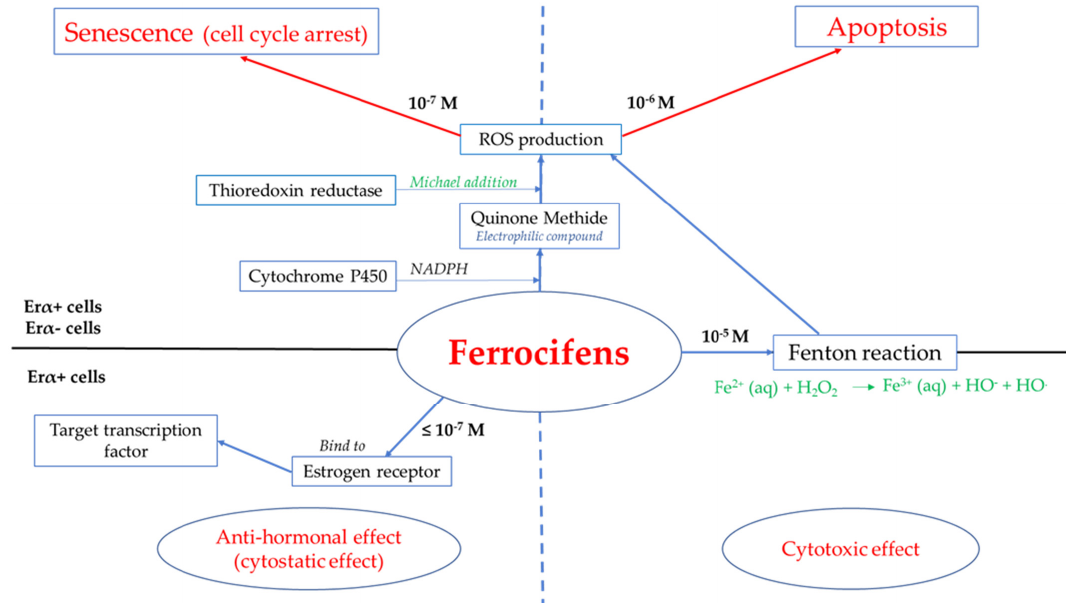
Figure 2. Ferrocifen mechanisms of action at the cellular level: at a concentration ≤ 10 − 7 M, ferrocifens present a cytostatic effect; at a concentration > 10 − 7 M, ferrocifens present a cytotoxic effect.